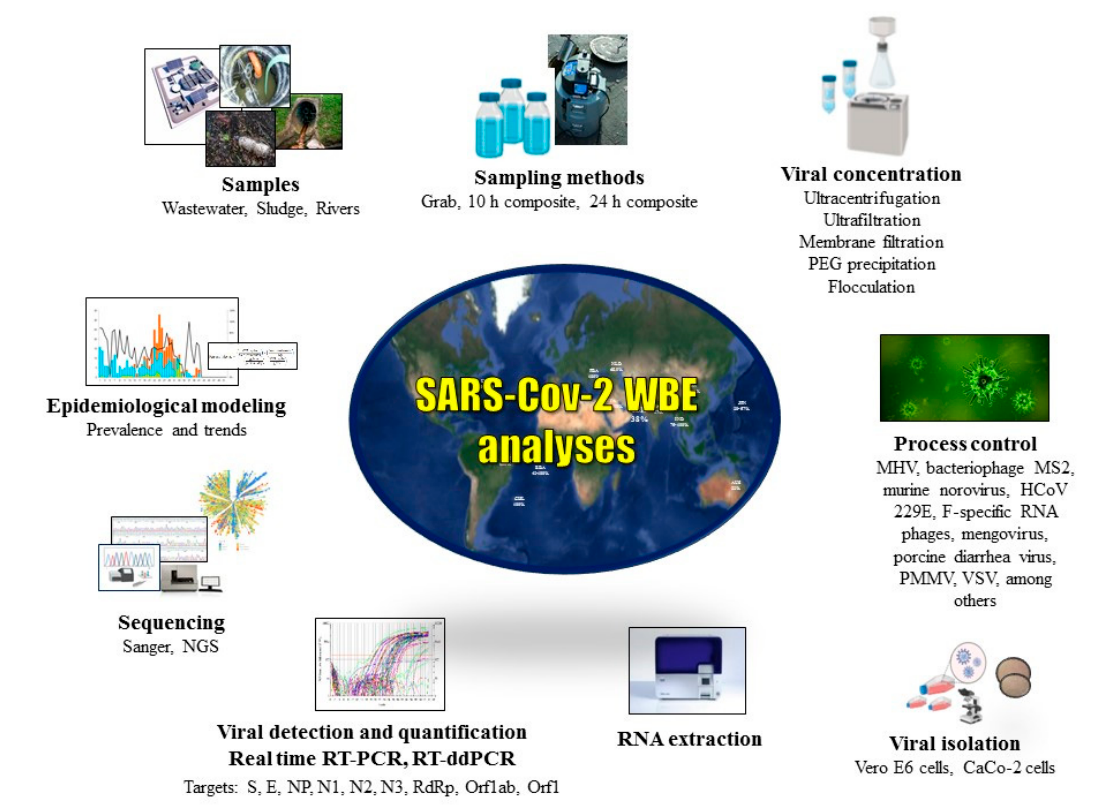
Figure 1. A summary of methods used in the wastewater-based epidemiology (WBE) analyses. PEG, PEG, polyethylene glycol; MHV, murine hepatitis virus; HCoV, human coronavirus, PPMV, pepper mild mottle virus, VSV, vesicular stomatitis virus.